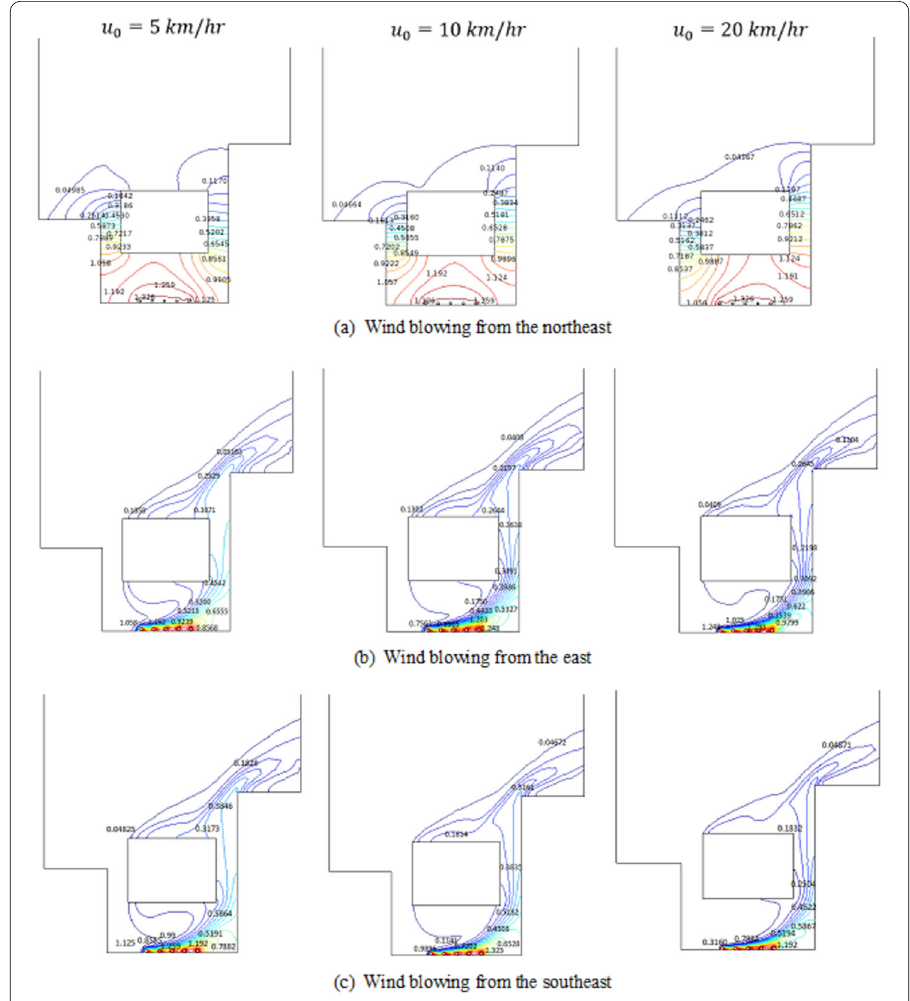
Figure 5 Contour lines of CO 2 concentration obtained from the model with various features of inlet wind: wind speed of 5 km/h (first column), 10 km/h (second column), and 20 km/h (last column); and wind blowing towards 3 different directions: ( a ) northeast; ( b ) east; ( c ) southeast